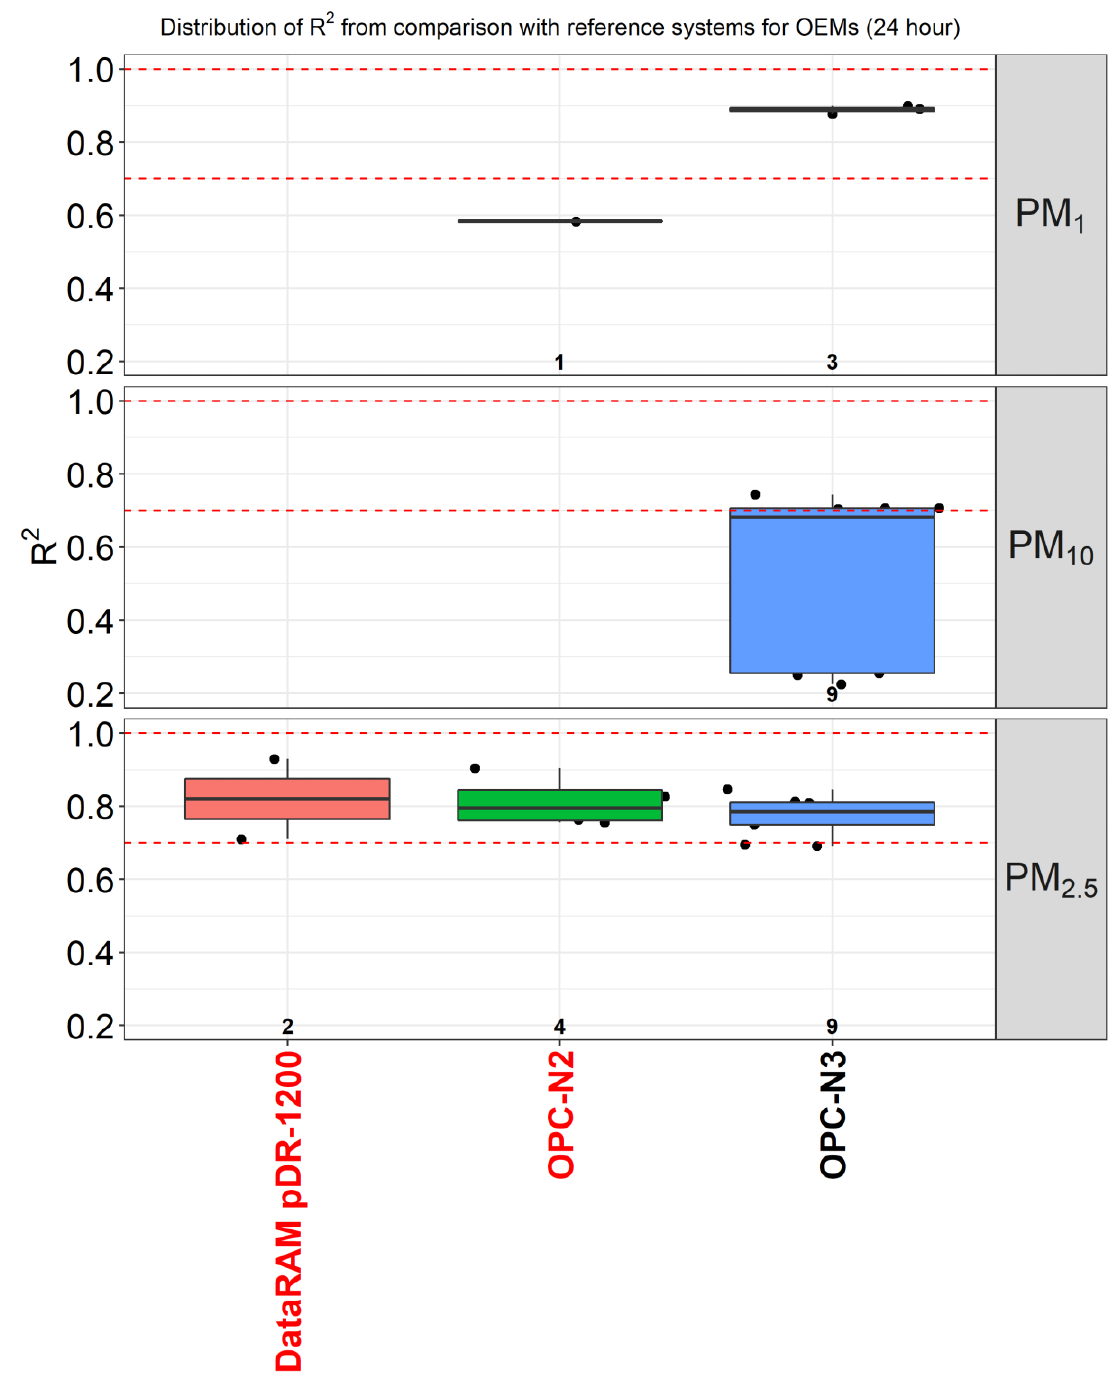
Figure A6. Distribution of R 2 from the comparison of all OEMs against reference systems. Records were averaged over a time-scale of daily data. Numbers in blue and black indicate the number of open source and black box records, respectively. Names of “living” and “non-living” sensors are indicated by black and red labels on the x-axis, respectively.